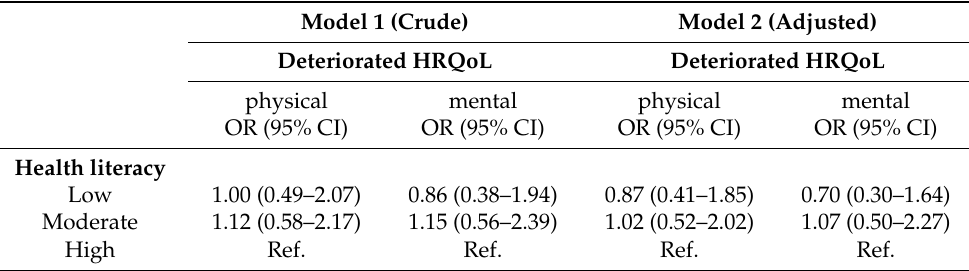
Table 4. Association of health literacy (HL) with deteriorated health-related quality of life (HRQoL), crude (model 1) and adjusted for Charlson comorbidity index, vascular access, dialysis effectiveness, age and gender (model 2): results of logistic regression analysis leading to odds ratios (OR) and 95% confidence intervals (CI), sensitivity analysis with exclusion of those who died; n = 324, patients from 20 dialysis clinics in